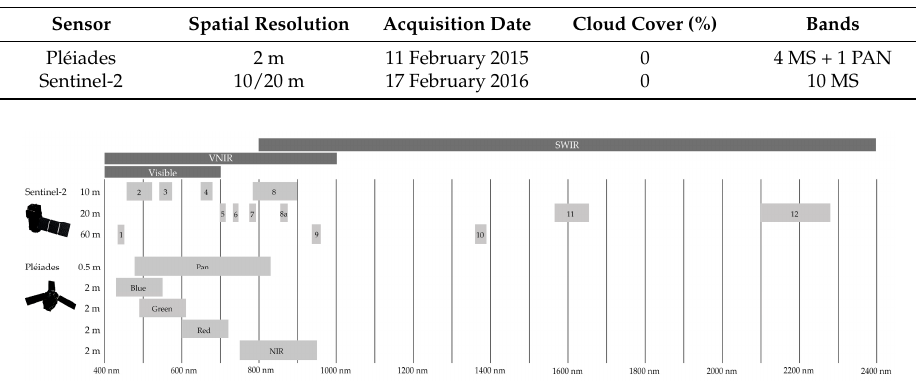
Table 2. Overview of selected Earth Observation (EO) datasets. MS: multi-spectral; PAN: pan-chromatic.